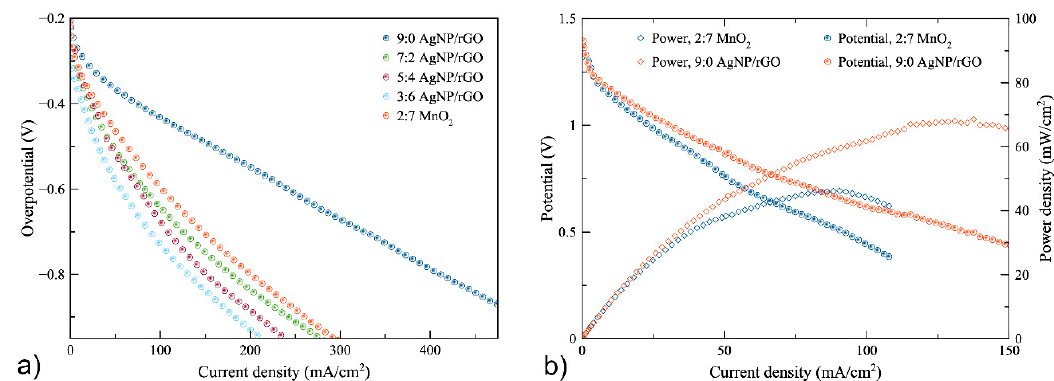
Figure 5. ( a ) overpotential of the 9:0, 7:2, 5:4 and 3:6 AgNP/rGO air-cathodes and the 2:7 MnO 2 air-cathode ( b ) polarization characteristics of the zinc–air batteries using the 9:0 AgNP/rGO cathode and the 2:7 MnO 2 cathode.